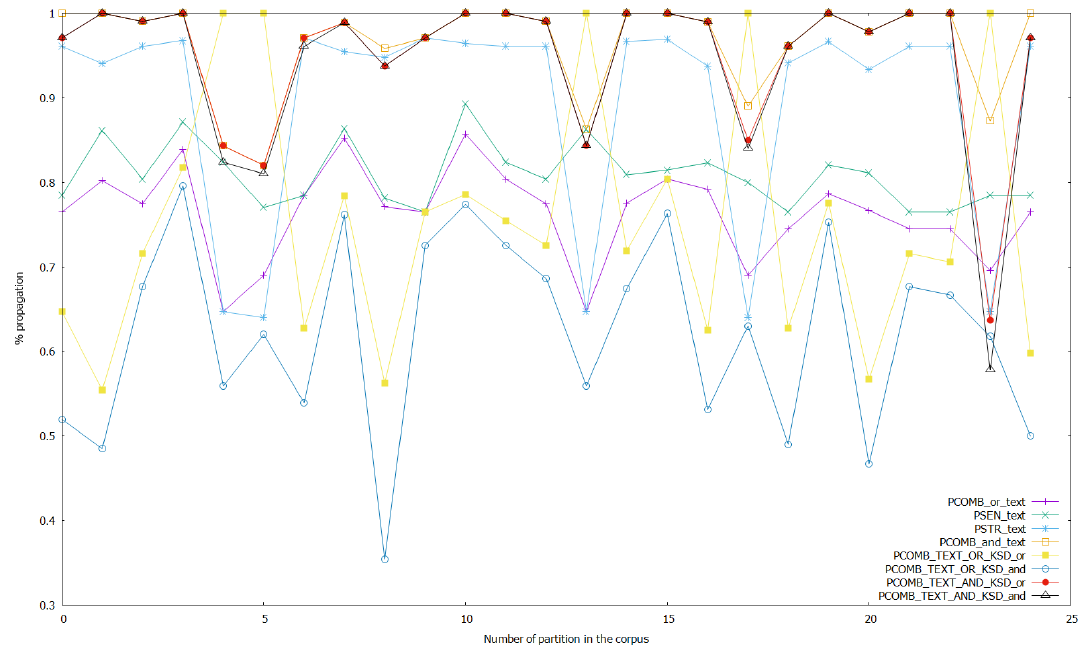
Figure 8. Results of the experiments with the sentiment, stress, and combined analyses on text, and with the combined analyses on text and keystroke data with threshold set to 0.7 in the ANNs that work with text data.